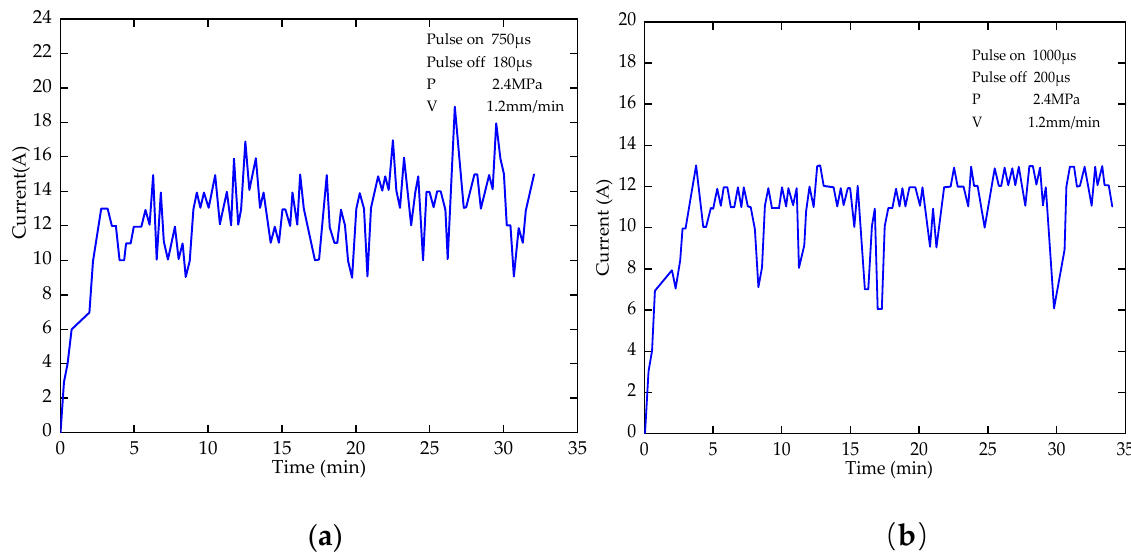
Figure 15. Current acquisition diagram; ( a ) sampling current with pulse on 750 µ s and pulse off 180 µ s; ( b ) sampling current with pulse on 1000 µ s and pulse off 200 µ